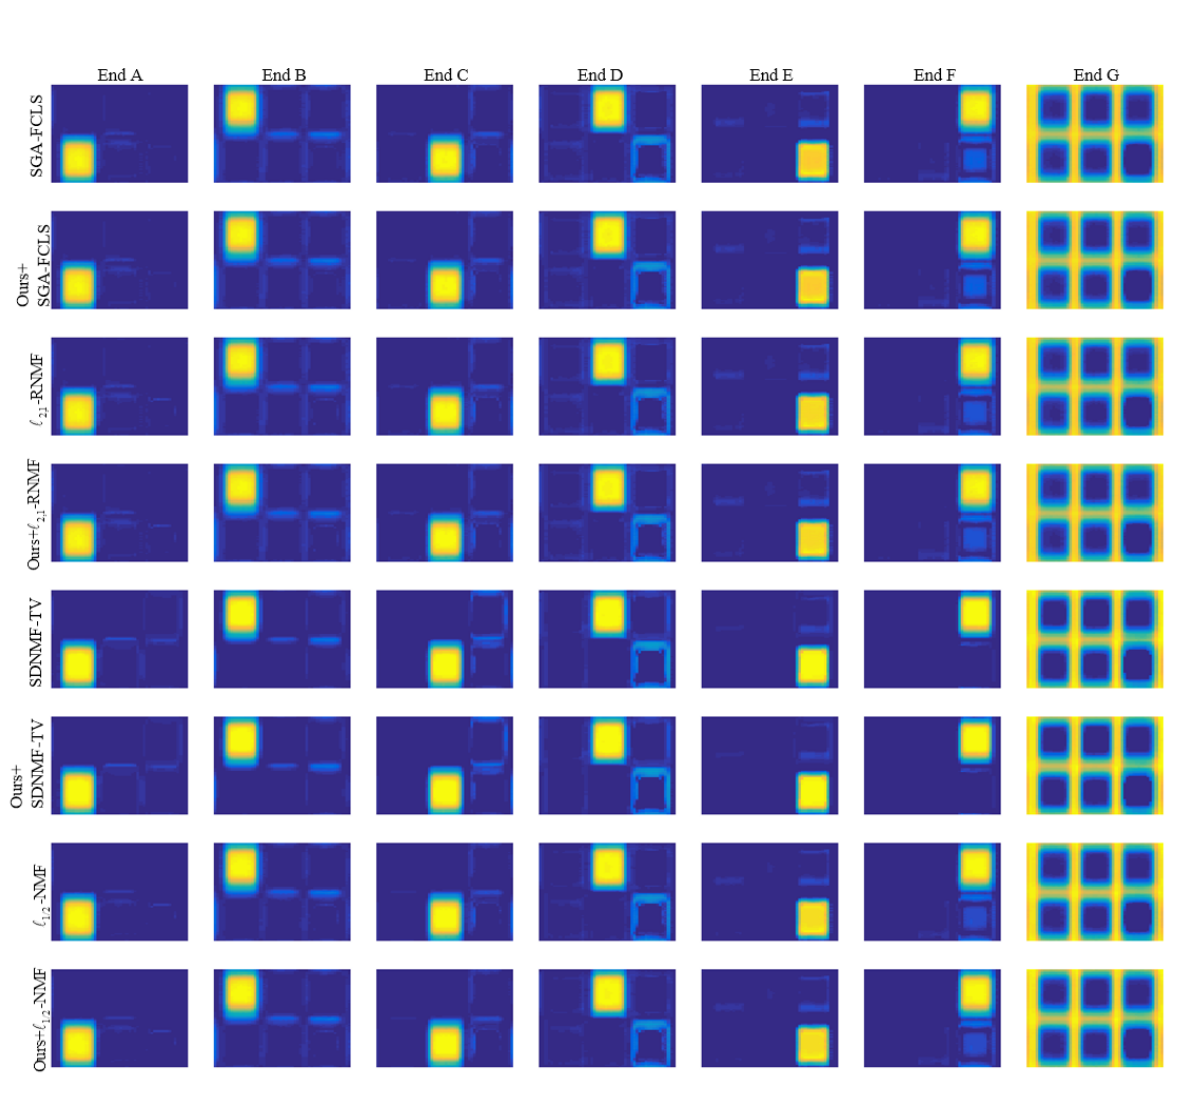
Figure 13. The abundance maps estimated by different algorithms with/without our